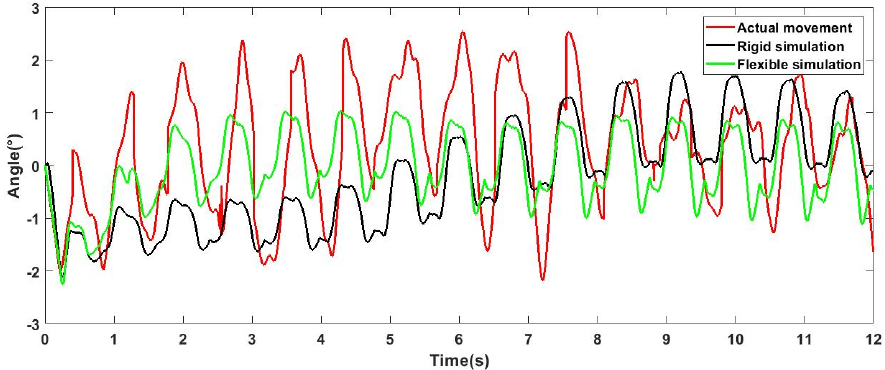
Figure 18. Deviation diagram of robot yawing direction.